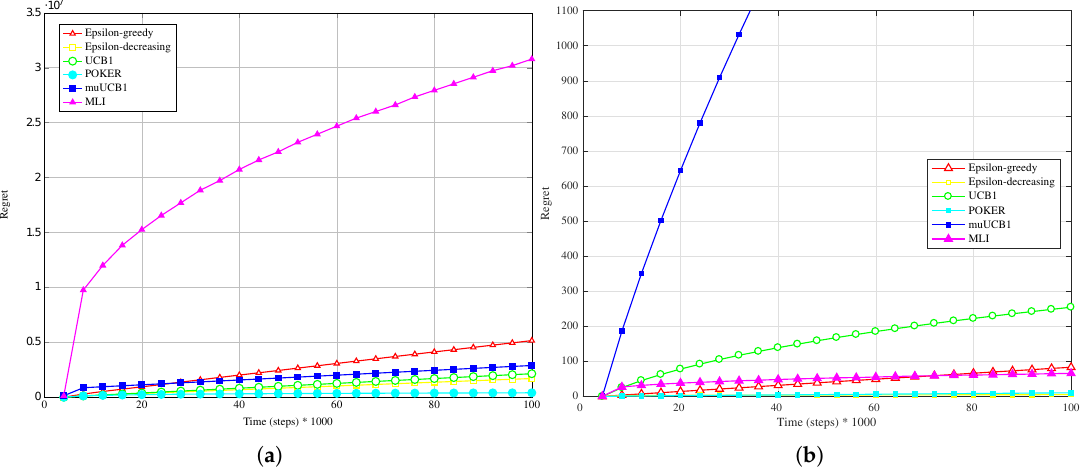
Figure 11. Performance in terms of regret of the six considered algorithms, with real captured data used as reward and T U / T M = 1. ( a ) linear conversion; ( b ) logarithmic conversion.